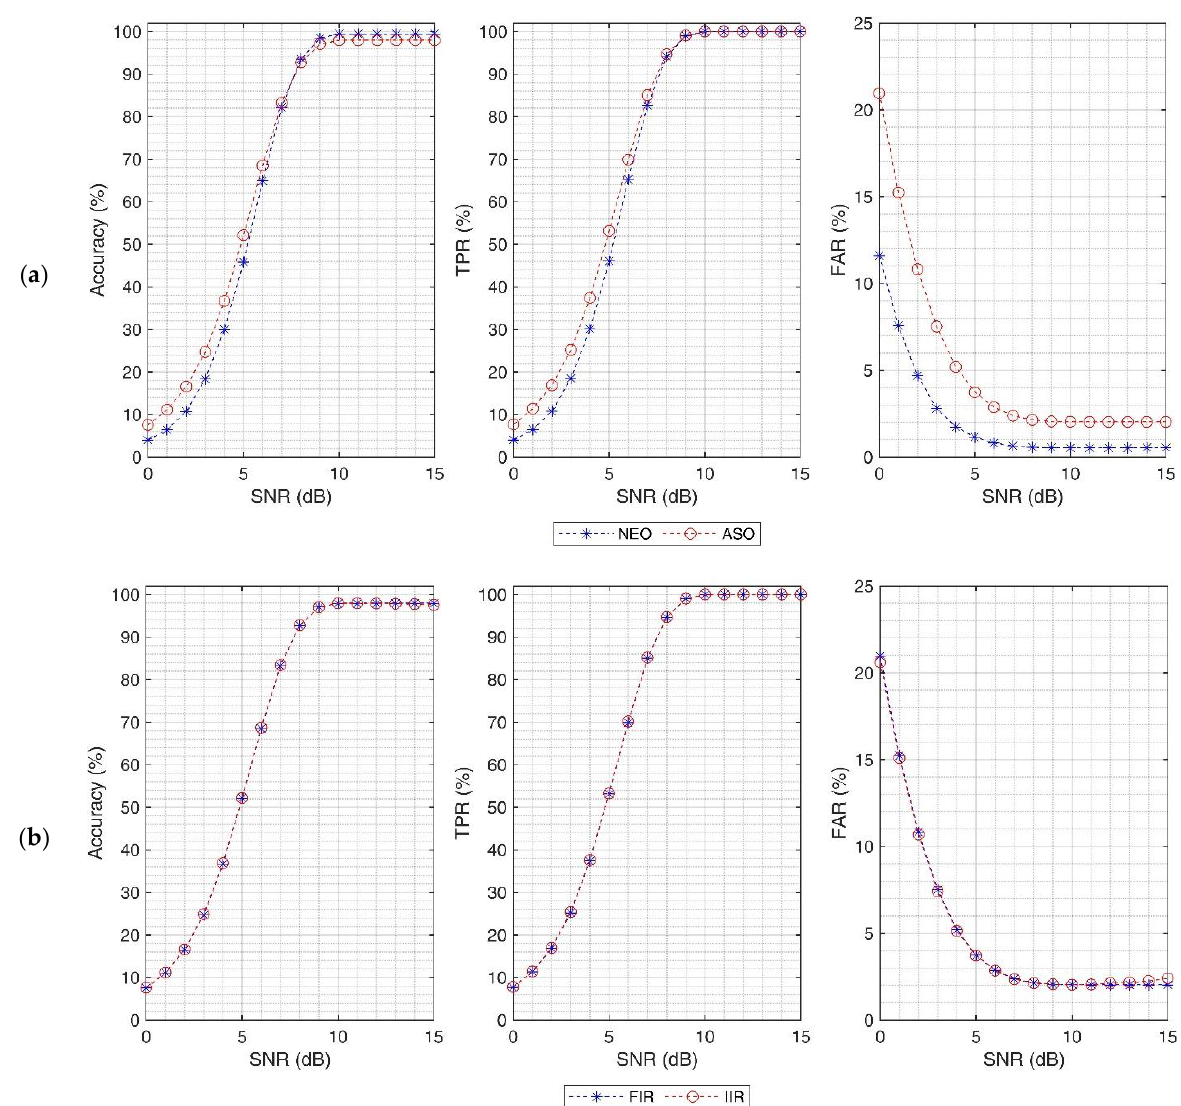
Figure 9. ( a ) The non-linear energy operator (blue) and amplitude slope operator (red) detection results with k = 4 with known standard noise. ( b ) ASO with hamming window of 17 (blue) and 4th equivalent IIR (red). The multiplier factor maximizing the performance was found to be 5.